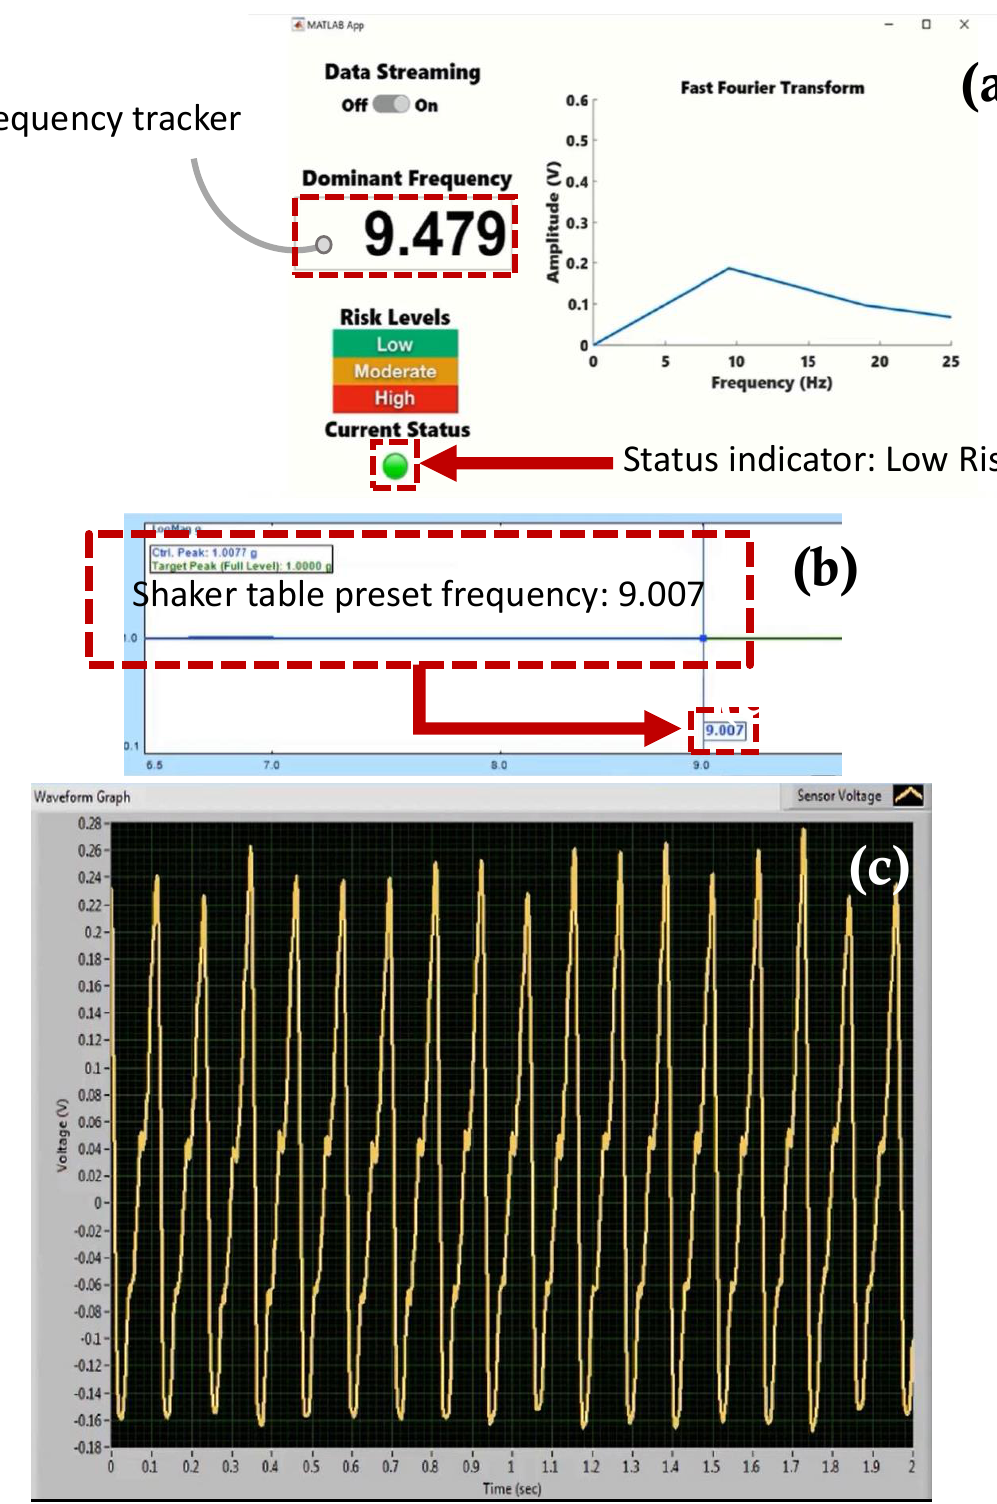
Figure 17. Screen captures of the self − powered, self − contained, vibration sensor system taken from the demonstration experiment: ( a ) custom developed fault detection app with a frequency tracker feature and status indicator for risk monitoring, ( b ) EDM shaker table vibration control software with preset frequency monitor, and ( c ) sensor voltage waveform monitor at preset frequency 9.007 Hz.